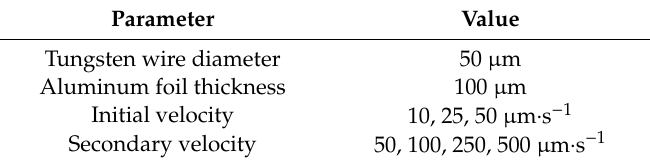
Table 3. Machining